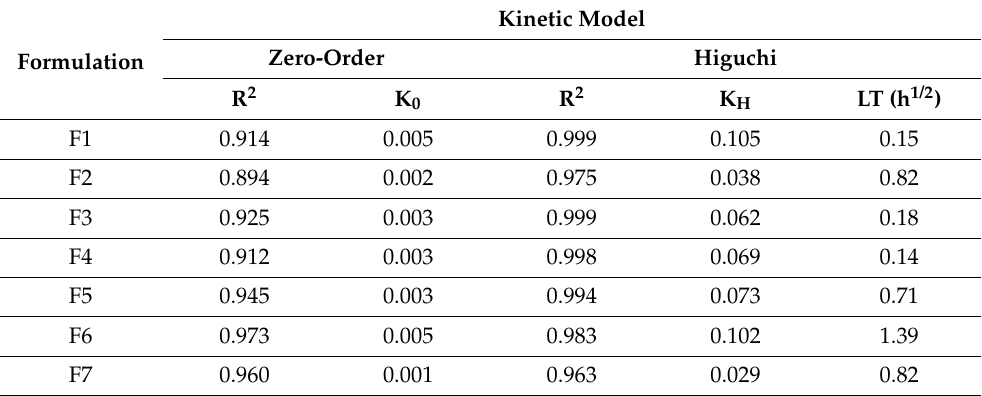
Figure 5. In vitro release of ETD from gel formulations (mean ± SD, n = 6). Results are expressed as the amount (mg) of drug detected in the acceptor fluid, which penetrated the synthetic membrane (Cuprophan) in accordance to 1 cm 2 of membrane. Formulations F2, F3, F4, F5, and F7 showed significant differences ( p < 0.005) in comparison to the F1 gel which had the highest amount of ETD release).